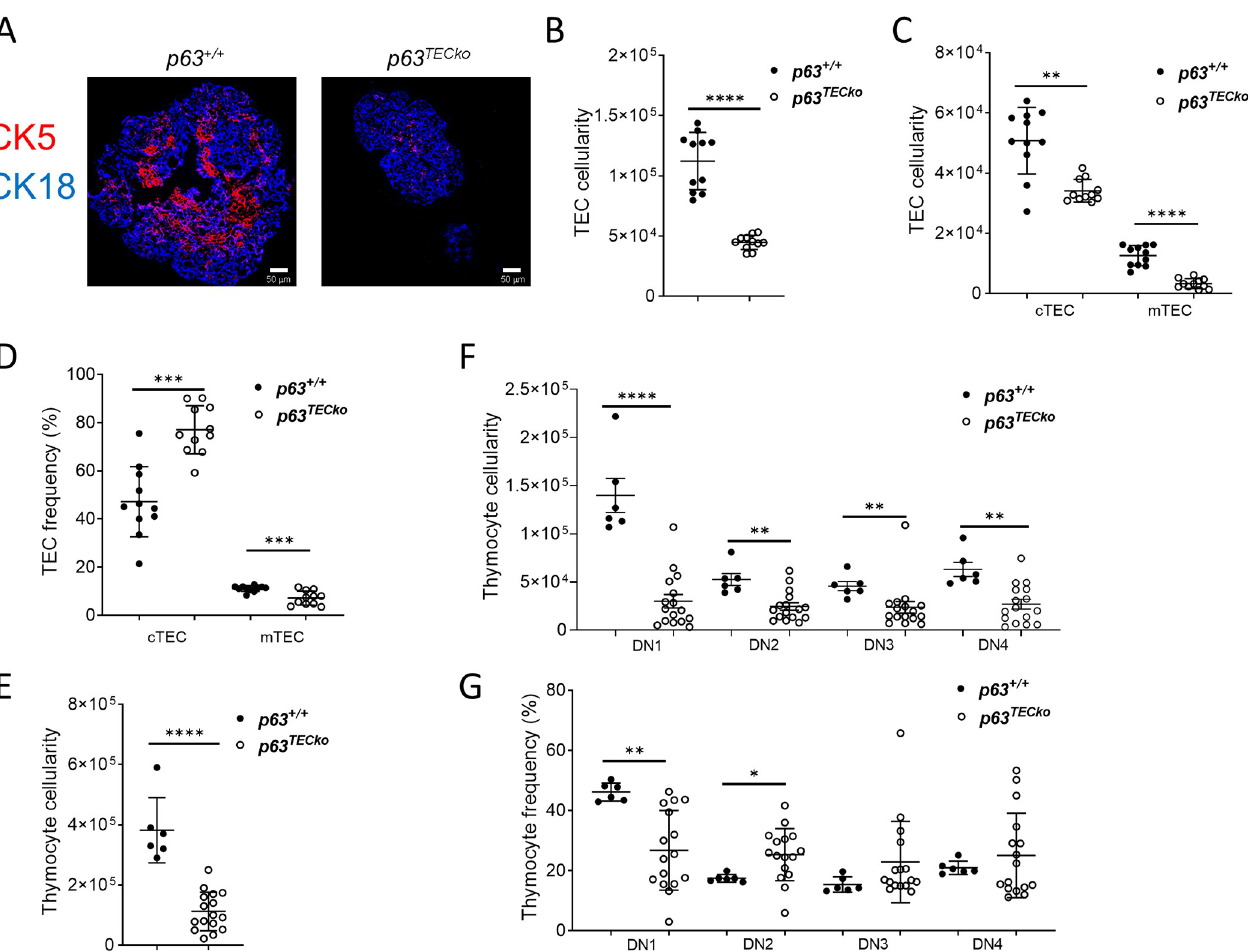
Fig 2. p63 TECko mice have decreased TECs and DN1 cells in embryonic mice. Fig 2A shows CK18 (blue), CK5 (red) staining. The scale bars are 50 μ m. Absolute TEC cellularity (2B, p < 0.0001) numbers of TEC subsets (2C; cTEC, p = .0014; mTEC, p < 0.0001) and frequency of TEC subsets (2D; cTEC,p = 0.001; mTEC,p = 0.008)) based on (CD45 − EpCAM + of cTECs (Ly51 + UEA − 1 - ) and mTECs(Ly51 - UEA-1 + I-A b+ ) are shown. Flow cytometric analysis for the cell- surface expression of CD44 and CD25 on thymocytes isolated from p63 TECko and p63 +/+ mice. Thymocyte cellularity of total thymocytes (2E, p = < 0.0001) and DN subsets (2F; DN1, p = 0.0004; DN2, p = 0.0151; DN3, p = 0.0243; DN4, p = 0.0036) frequency of DN subsets (2G; DN1, p < 0.0001). This experiment was performed 2 times with at least 3 mice per group. P values are